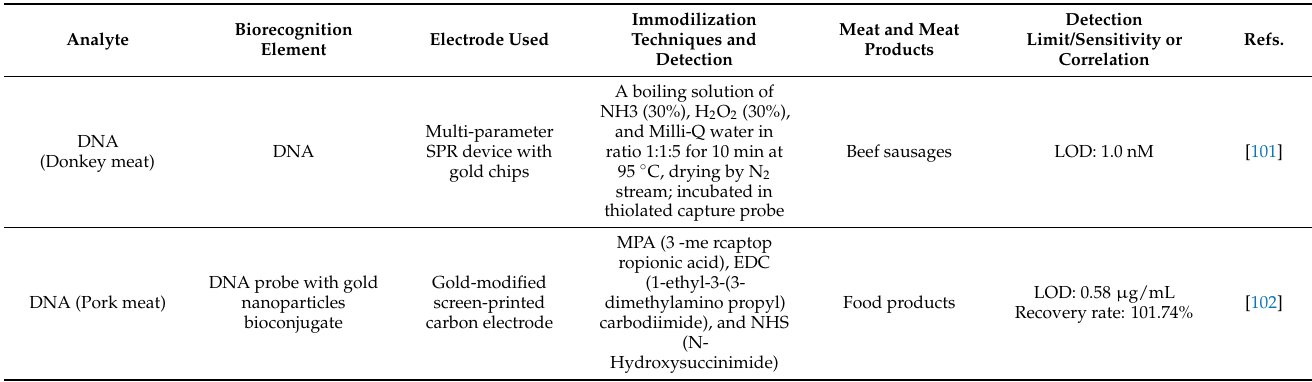
Table 4. Biosensors for the detection of various adulterants, antibiotics and drug residues, and additives in meat and meat